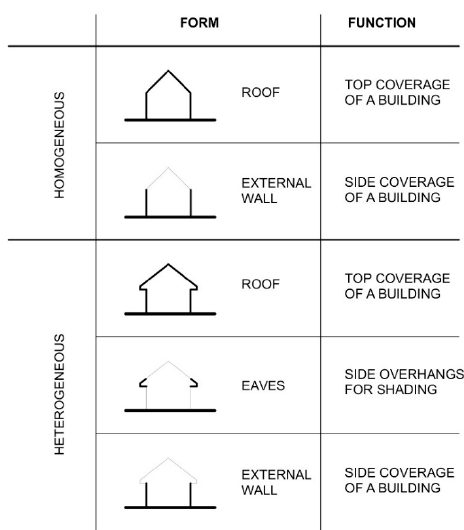
Figure 7. Heterogeneity in a conventional roof structure showing the heterogeneous forms of the roof and eaves.